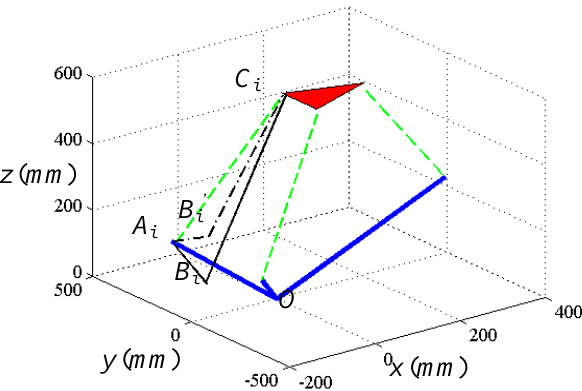
Figure 7. Different configurations for inverse